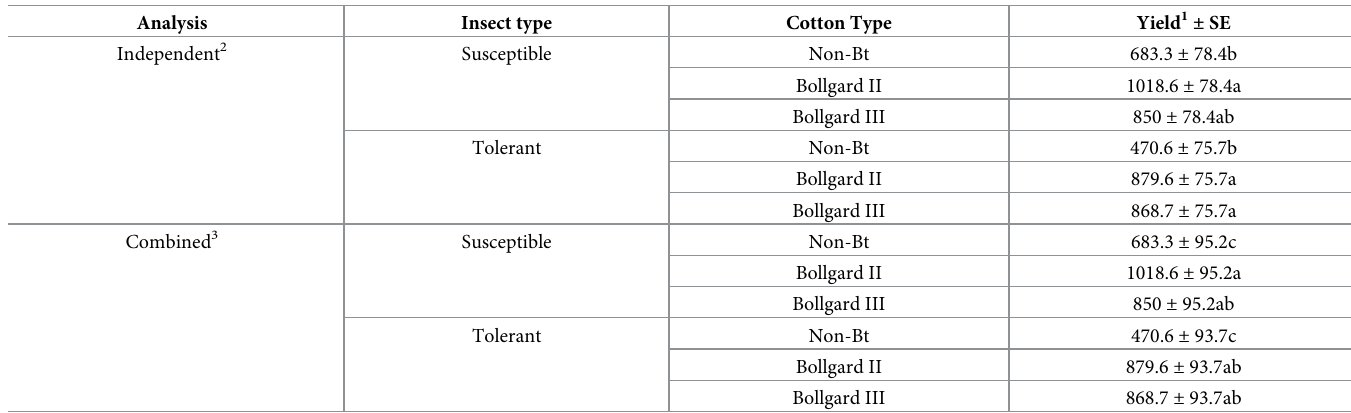
Table 4. Mean lint yields for cotton types exposed to susceptible and tolerant H . zea in large field